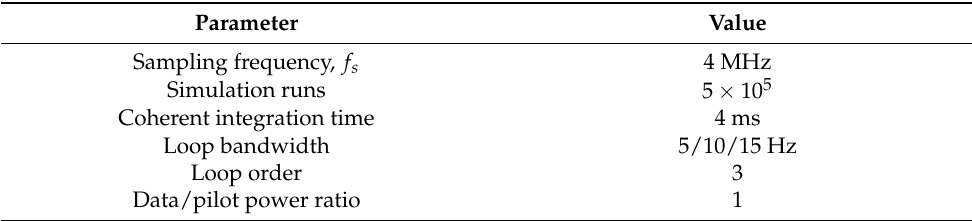
Table 1. Parameters used for the semi-analytic simulations. Parameter